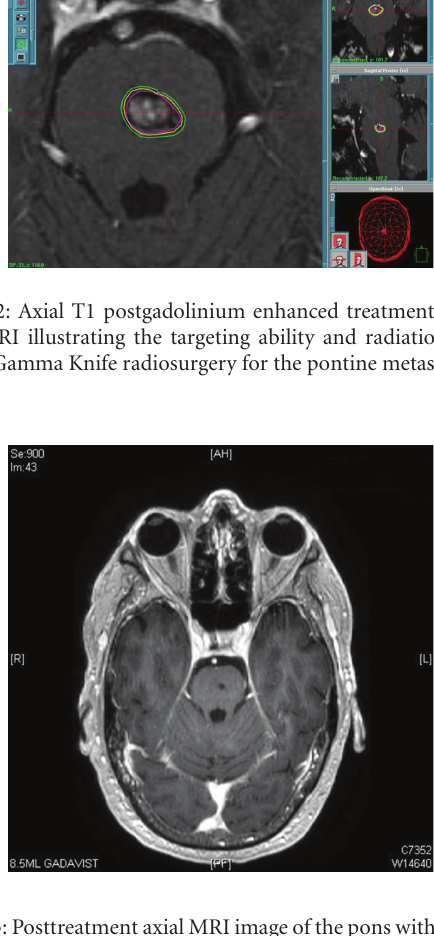
Figure 3: Posttreatment axial MRI image of the pons with complete ablation of the pontine metastasis and no further visible disease within the